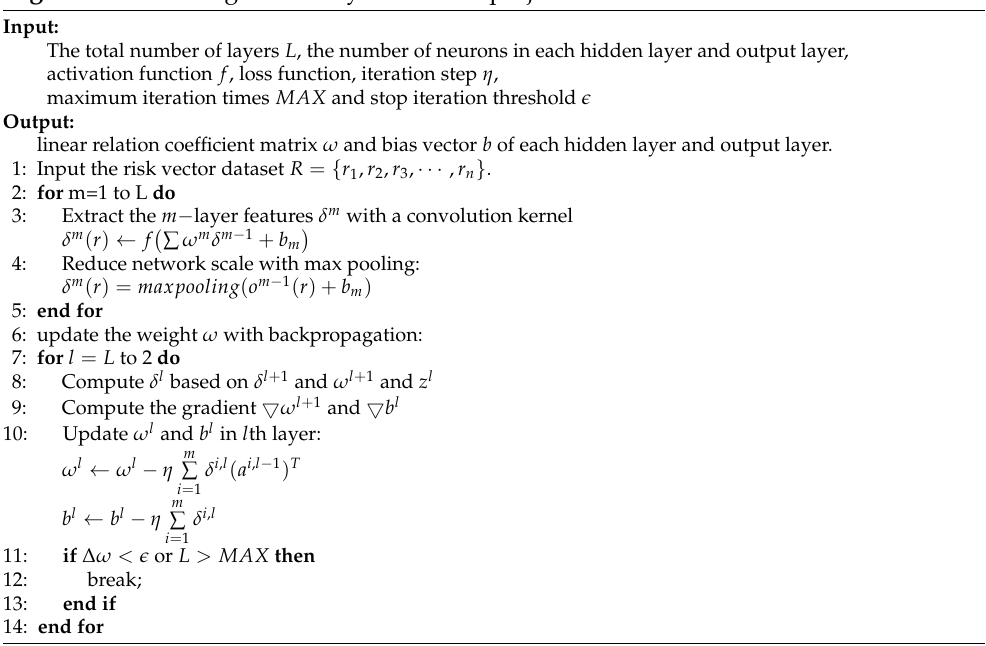
Algorithm 1 Training of security situational project